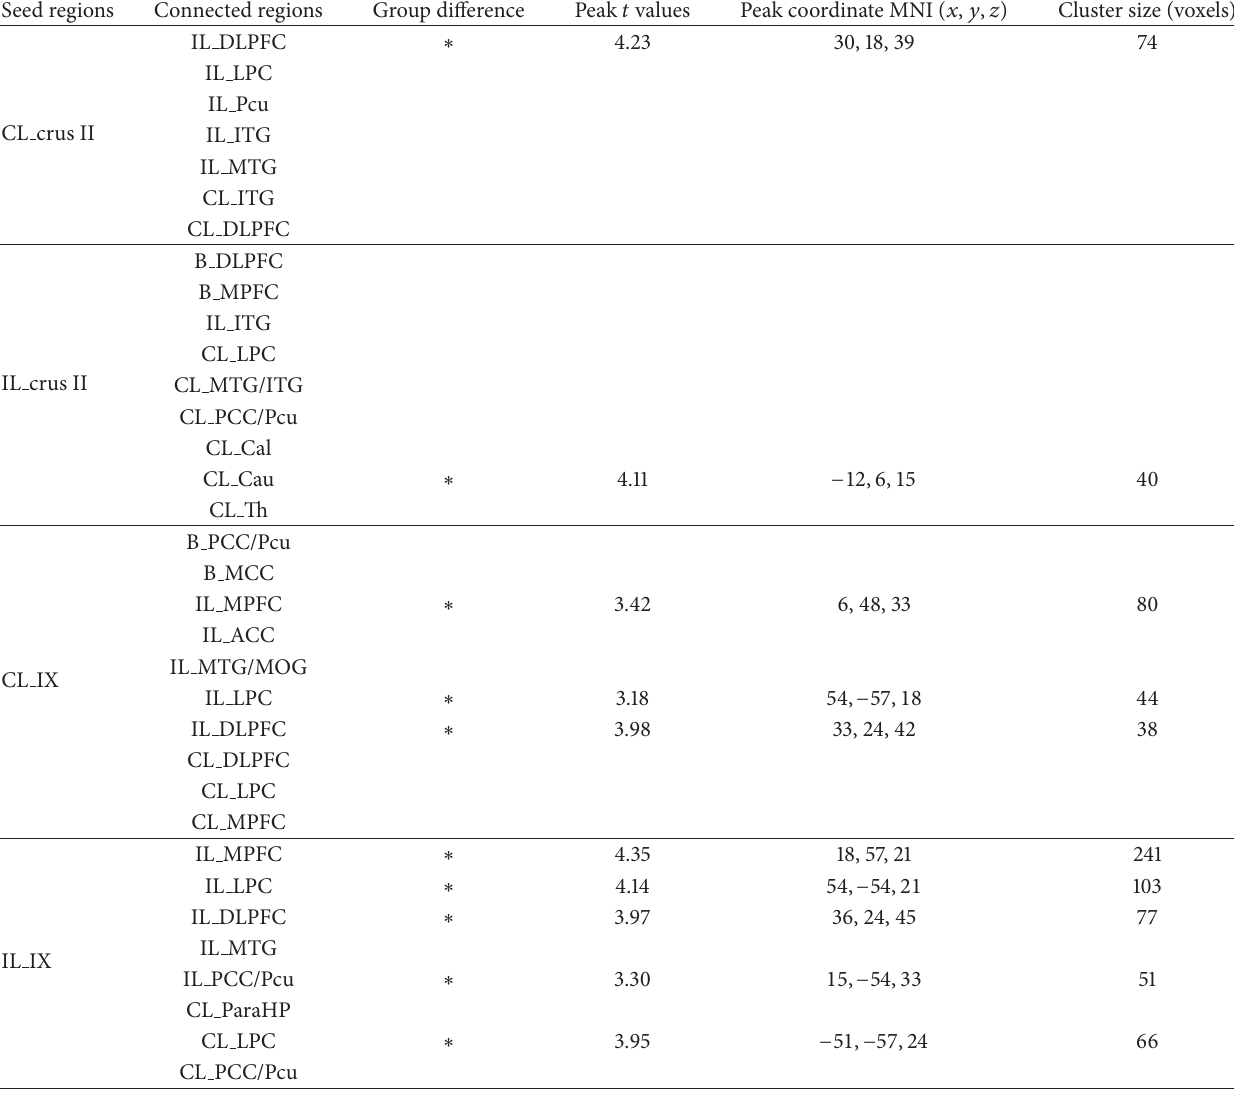
Table 2: The rsFCs of the cerebellar crura II and IX in both of the control and patient groups and significant group differences in these rsFCs between healthy controls and stroke